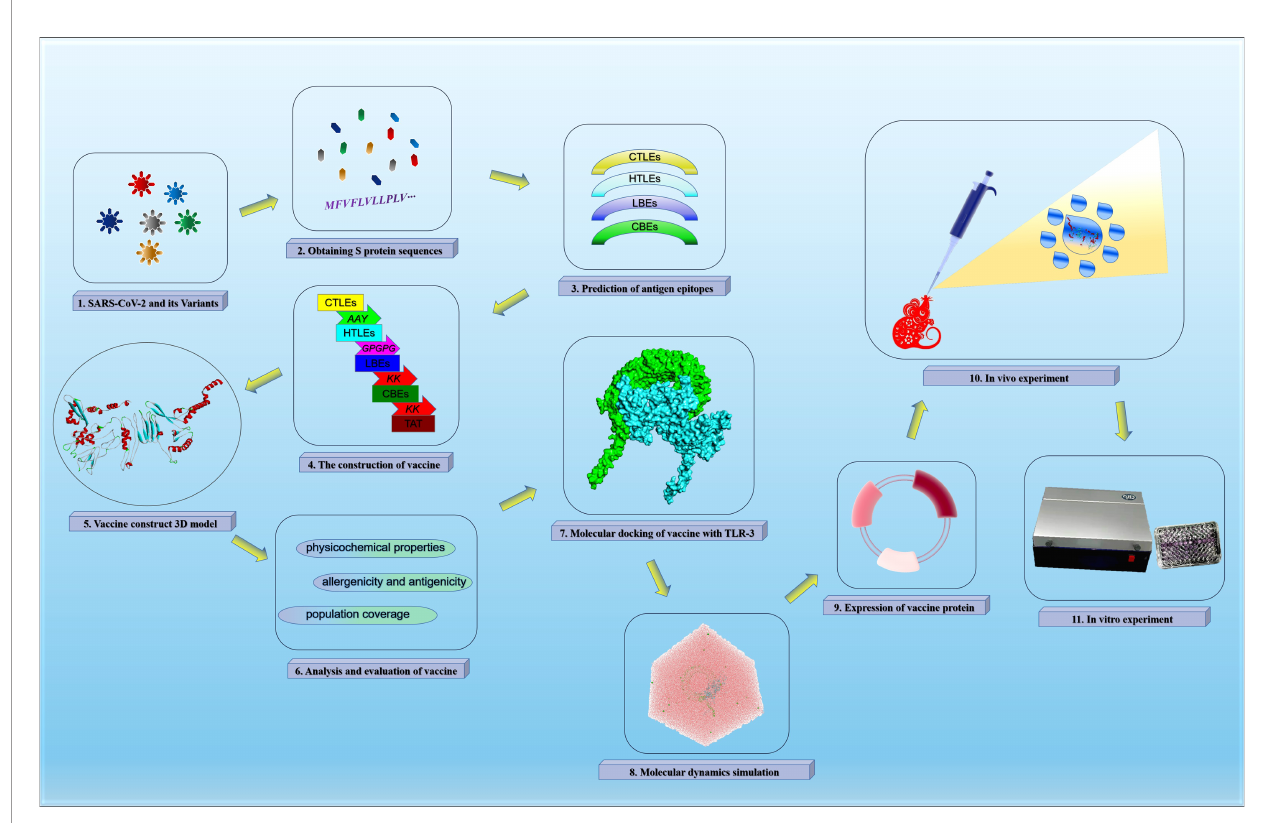
FIGURE 1 | The vaccine construction